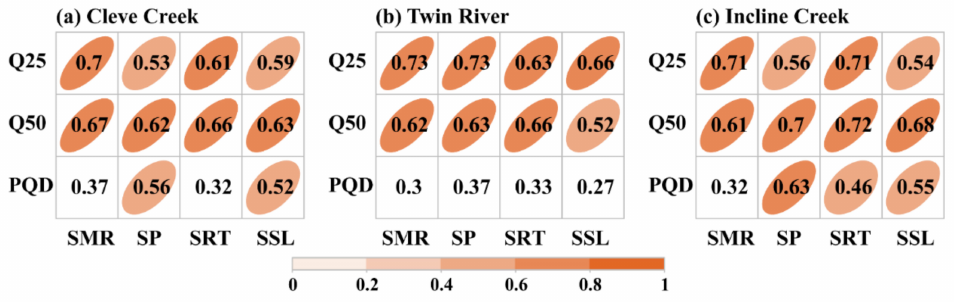
Figure 3. Correlation between snow indices (SMR, SP, SRT, and SSL) and streamflow timing variables (Q25, Q50, and PQD) at the watershed scale. The correlation is significant at the 0.05 significance level with colors.